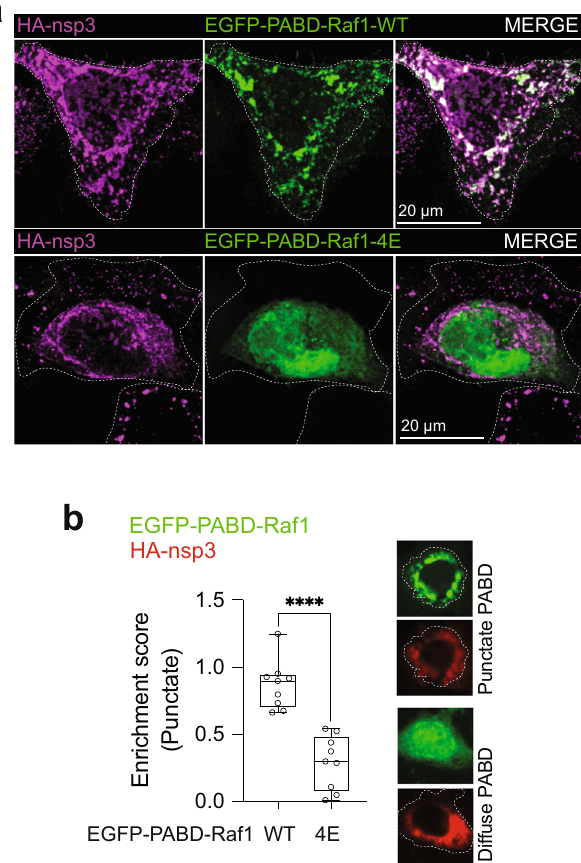
Fig. 7 PA accumulation at SARS-CoV-2 DMVs. a PA enrichment at SARS- CoV-2 nsp3-containing structures. Huh7-Lunet cells expressing the wildtype or mutant form of the PA sensor were transfected with the plasmid encoding HA-nsp3-4-V5 and 24 h later, cells were fi xed, immunostained with HA-speci fi c antibody and HA-nsp3 and EGFP-PABD were visualized by confocal microscopy. Maximum intensity projections are shown. b Using CellPro fi ler Analyst, a semi-supervised machine-learning classi fi er was trained to differentiate between punctate and diffuse signals of the EGFP-PABD sensor (top panel). A normalized enrichment score which indicates the probability of cells showing punctate EGFP-PABD localization to nsp3 fl uorescent signal across the whole-cell population is shown in the graph on the bottom panel as a scatterplot. The central line of the plot indicates median with fi rst and third quartiles are shown as boxes, and whiskers as lines. Signi fi cance was calculated by unpaired two-tailed t - test. **** p = 7.39734E-6. Data are represented as mean ± SD from three biologically independent experiments showing three technical replicates from each nsp3-4 induced DMVs did not decrease in AGPAT single and double KO cells (Fig. 6d, left two panels). However, in both cell pools we observed marked accumulations of multi-membrane vesicles (MMVs), indicating the formation of aberrant membrane structures (Fig. 6c, d).